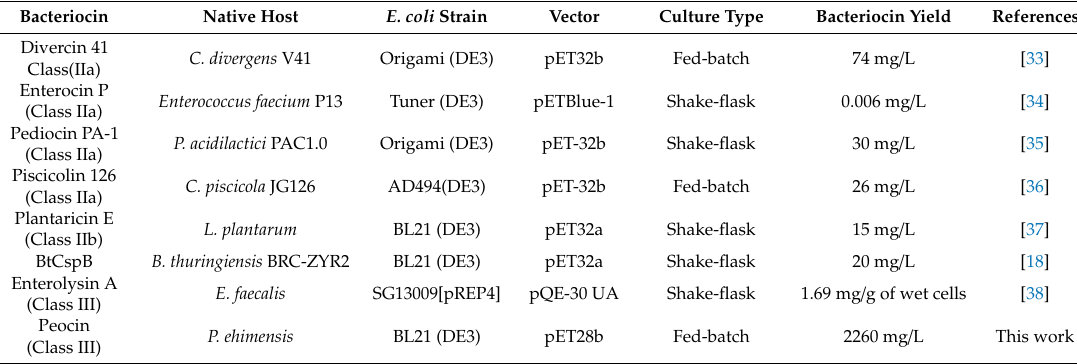
Table 3. Bacteriocin heterologous produced by E.